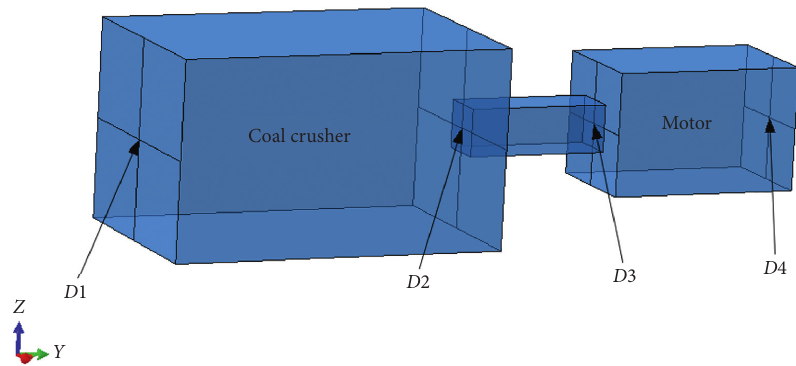
Figure 2: Positions of the disturbing forces.